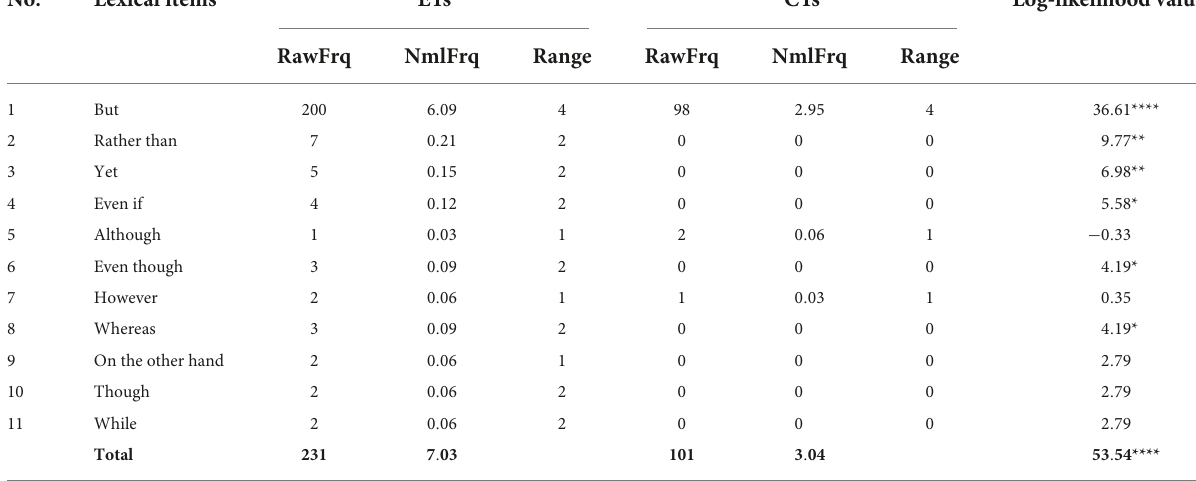
TABLE 4 Summary of comparative transitions in both sub-corpora.